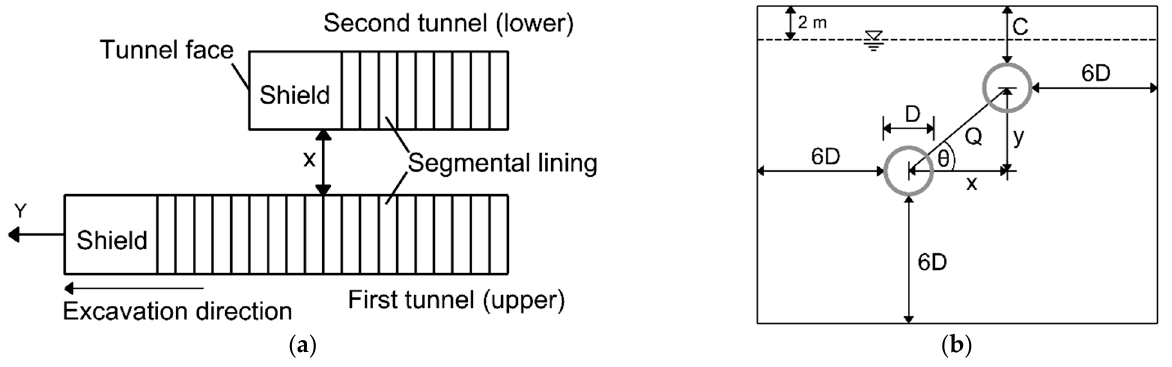
Figure 2. Typical ( a ) plan view, and ( b ) cross-section of the offset arrangement twin tunnels excavation sequence used in the study (not to scale). Table 1. Geometries of twin tunnels used in the finite element analyses.